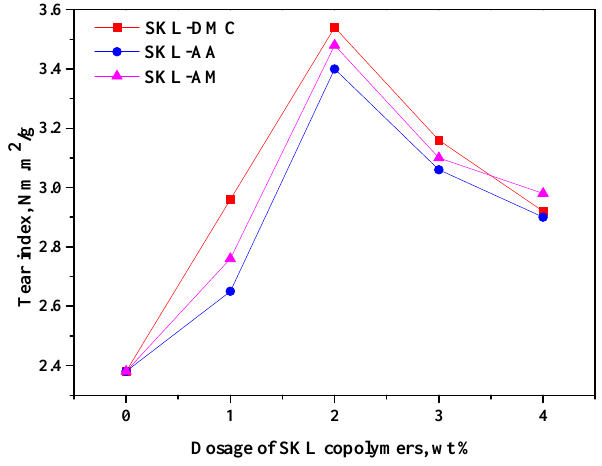
Figure 6. Tear index of paper sheets with various amounts of three additives added (SKL ‐ DMC, SKL ‐ AA, and SKL ‐ AM).